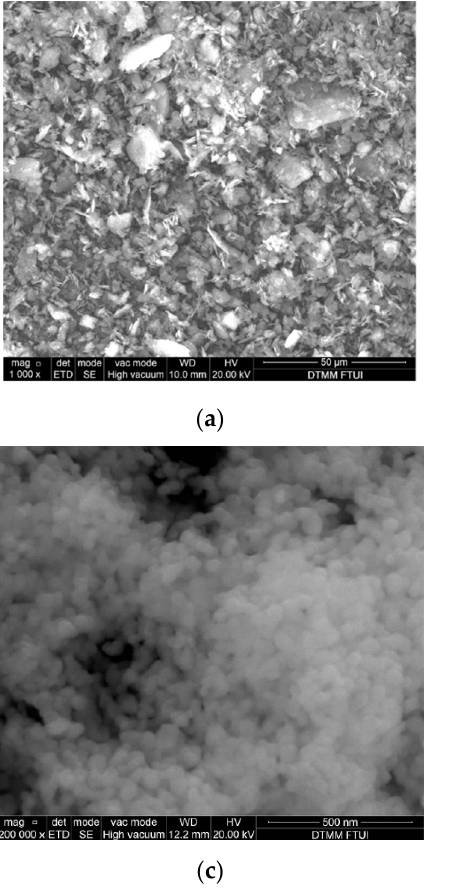
Figure 1. The microstructure and diffractogram of raw material ( a ) microstructure of metakaolin, ( b ) The diffractogram of metakaolin (* = SiO2, T = TiO 2 ), ( c ) the microstructure of nano-zirconia, ( d ) diffractogram of zirconia.